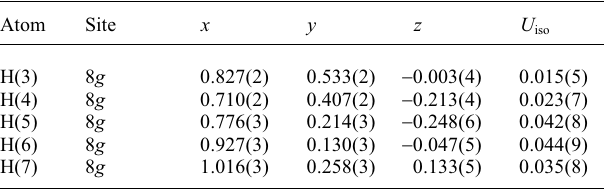
Table 2. Atomic coordinates and displacement parameters (in Å 2 )